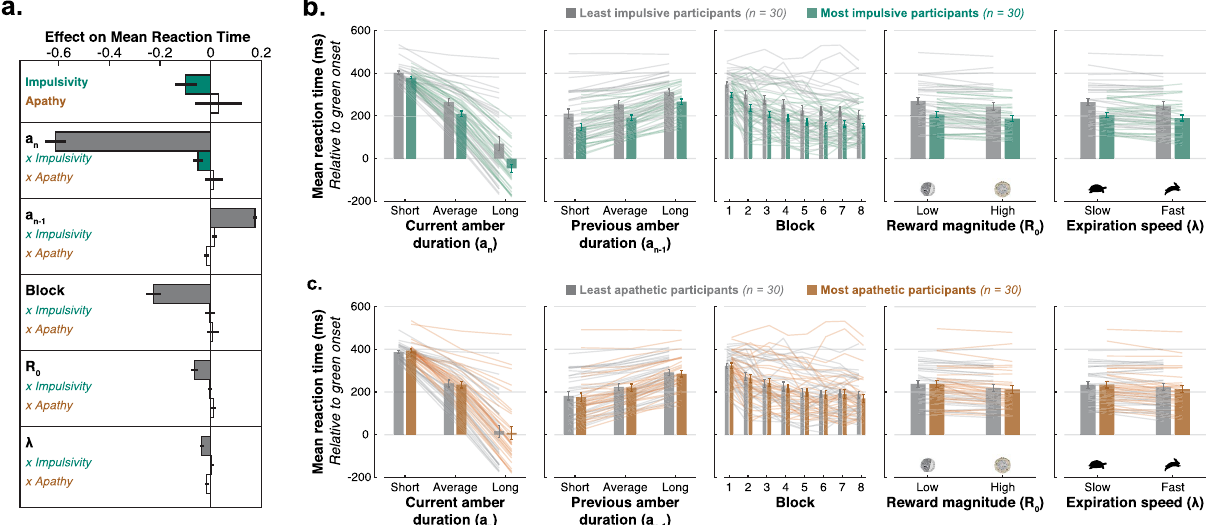
Figure 3. Impulsivity is associated with an all-encompassing pre-emptiveness to respond. ( a ) Parameter estimates of the linear mixed-effect model of mean RT (model controlling for Age and Gender; see Table S2— Model 2). Coloured bars show significant effects ( p < 0.05 ) and white bars non significant effects with standard error. Five experimental factors influenced the speed of the response: duration of the amber light of the current ( a n ) and previous ( a n − 1 ) trial, block index ( log -transformed), magnitude ( R 0 ) and decay rate ( (cid:31) ) of the reward. Impulsivity had a significant negative main effect and interaction with a n . This behavioural signature reflects a rigid tendency to respond early, regardless of the experimental condition. ( b–c. ) For visualisation purposes, the average reaction time (± s.e.m. ) is plotted as a function of the five experimental factors of interest, with a group median split on the impulsivity score ( b ) or apathy score ( c ). Individual data are plotted as separate lines of the corresponding